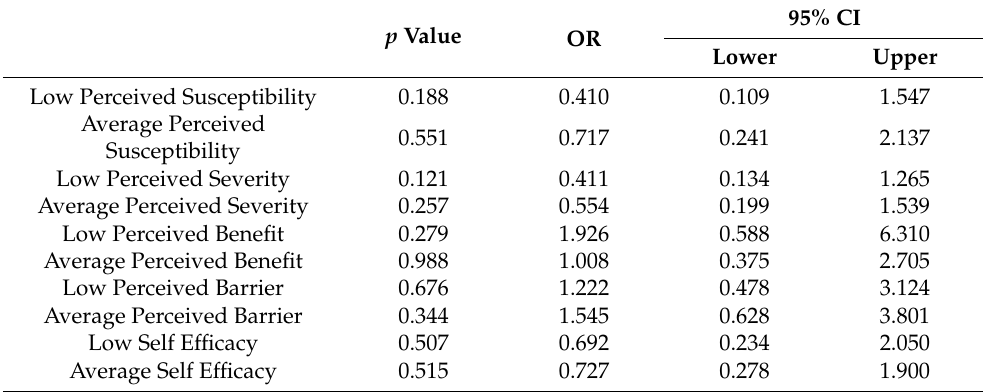
Table 9. Association between the variable